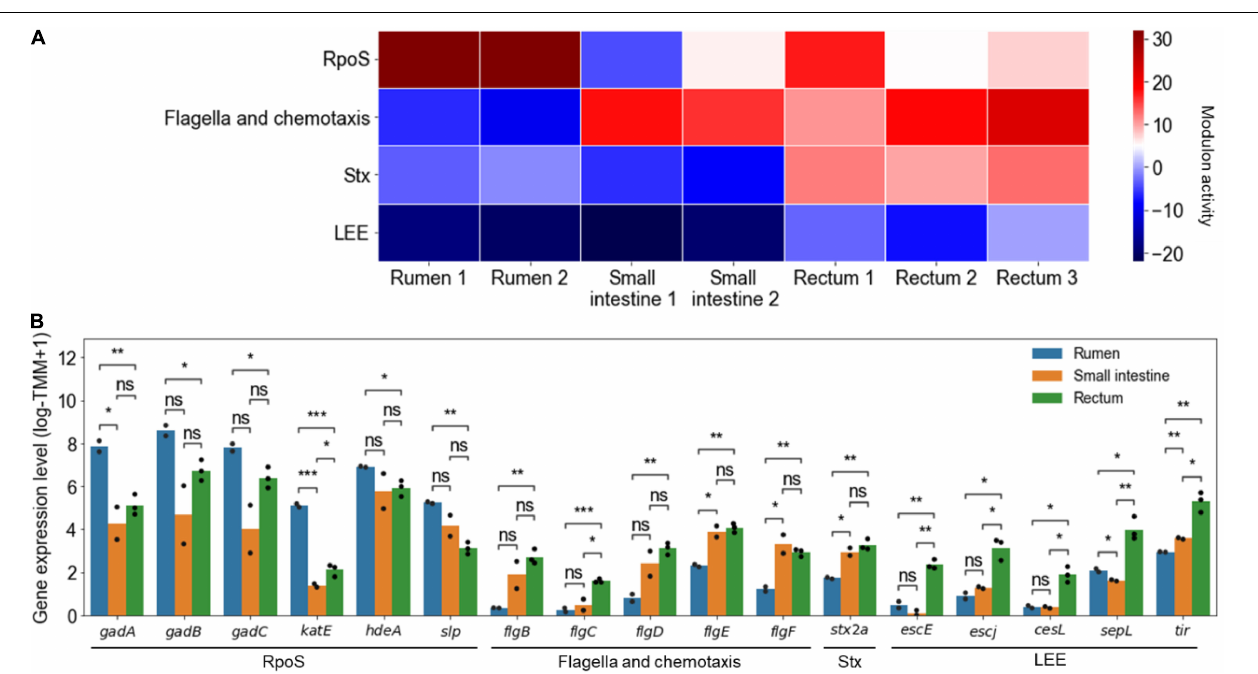
FIGURE 5 | The changed activities of the modulons obtained from the transcriptome data of EHEC EDL933 in the different sites of the bovine GITs. (A) Heatmap for the changed activities of the modulons in the different sites of the bovine GITs. The numbers on the bottom labels indicate a distinct single biological replicate. Red and blue represent the high and low activity of the modulon, respectively. (B) The bar plots for the expression levels of the element genes of the modulons in the different sites of the bovine GITs. The modulon names of the element genes are denoted below the plot. The distinct colors of the bars represent the sites where EHEC was cultured as indicated in the plot. Each dot on the bars represents a single biological replicate. Statistical significance was determined by the Student’s t -test (ns, not significant; * P < 0.05; ** P < 10 − 2 ; *** P < 10 − 3